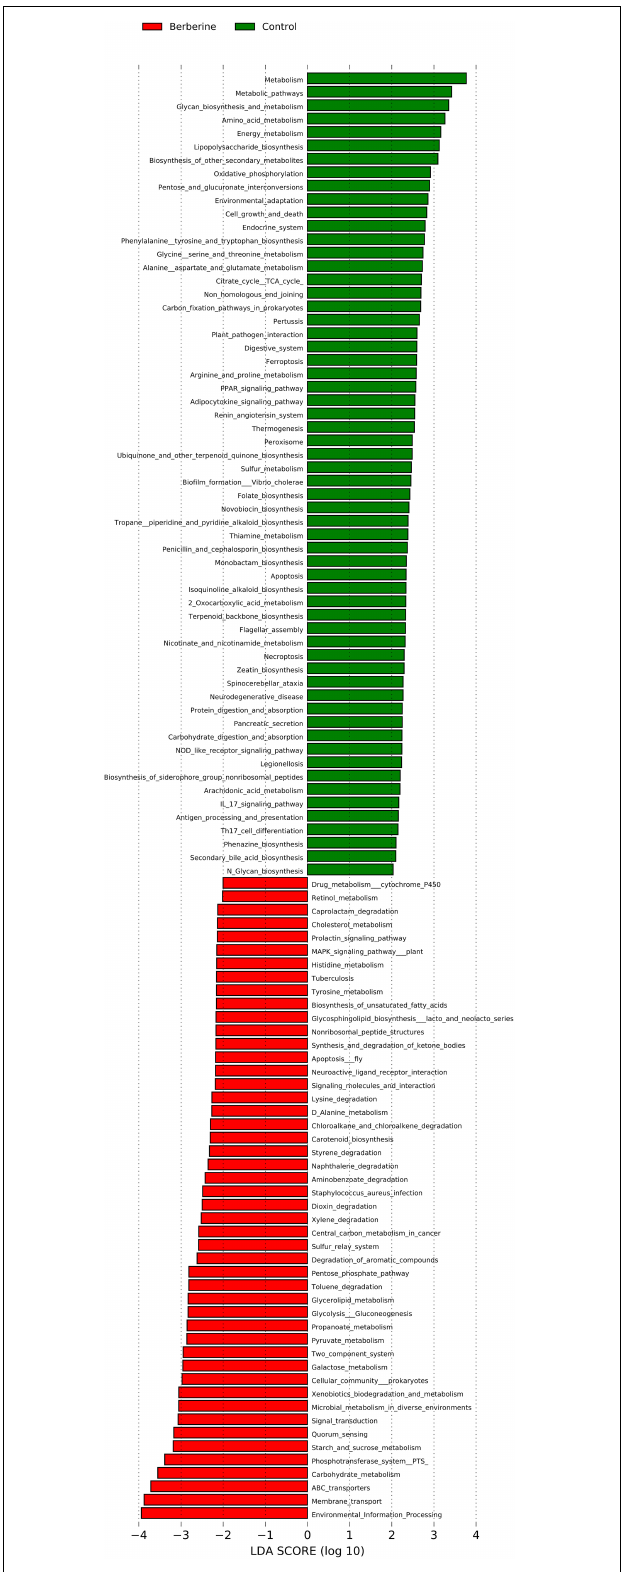
FIGURE 7 | Analysis of KEGG between control and berberine